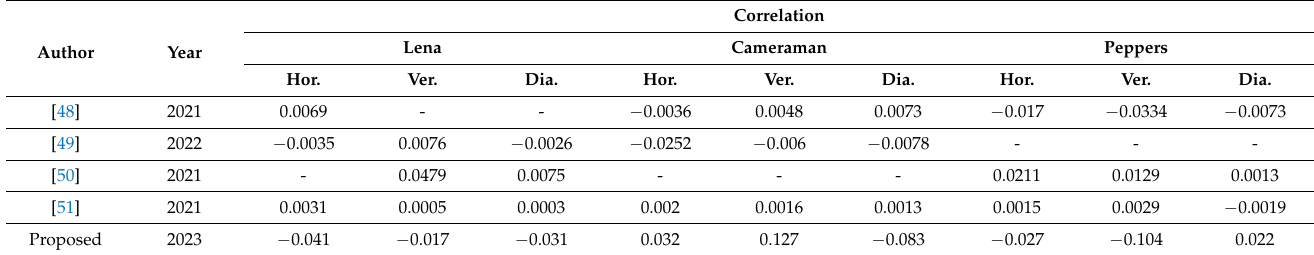
Table 6. Correlation comparison between proposed scheme and other